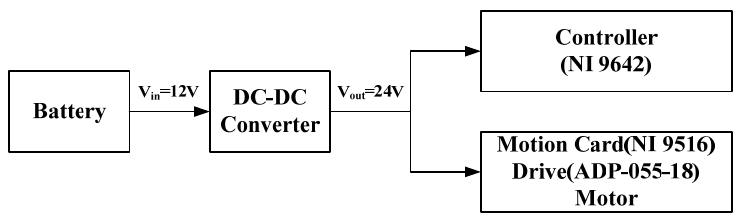
( c ) Figure 7. CV-Reflex charging. ( a ) Power end voltage, current and power curves; ( b ) battery end charging voltage, current and power curves; ( c ) SOC (%), actual voltage and temperature (°C) curves inside battery. Figure 8. Temperature rise curve comparison diagram. 5. Self-Sufficient Power Supply Evaluation When the solar energy charging system was completed, the availability of the equipment used